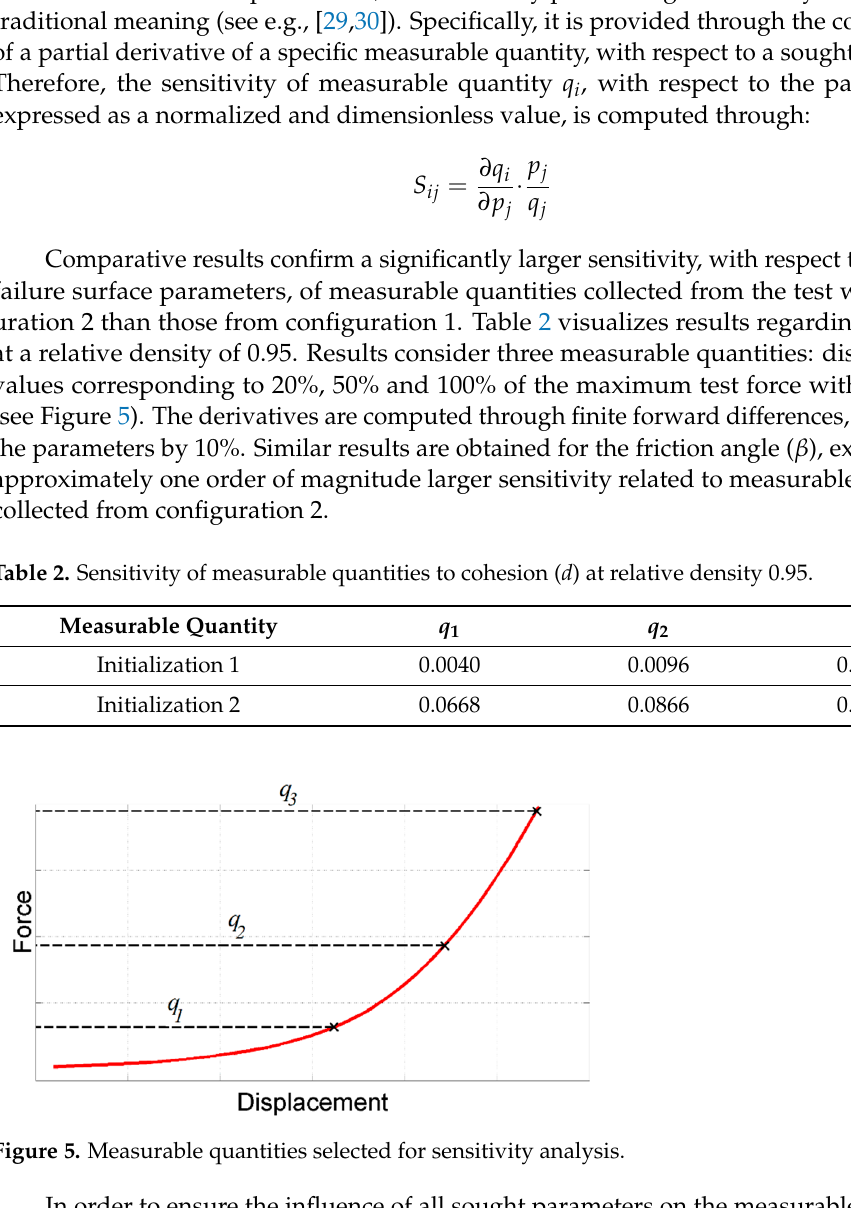
Figure 4. Adopted configurations for calibration through powder compaction tests: a flat cylinder ( a ), an inclined cylinder ( b ) and a combination of the two ( c ).